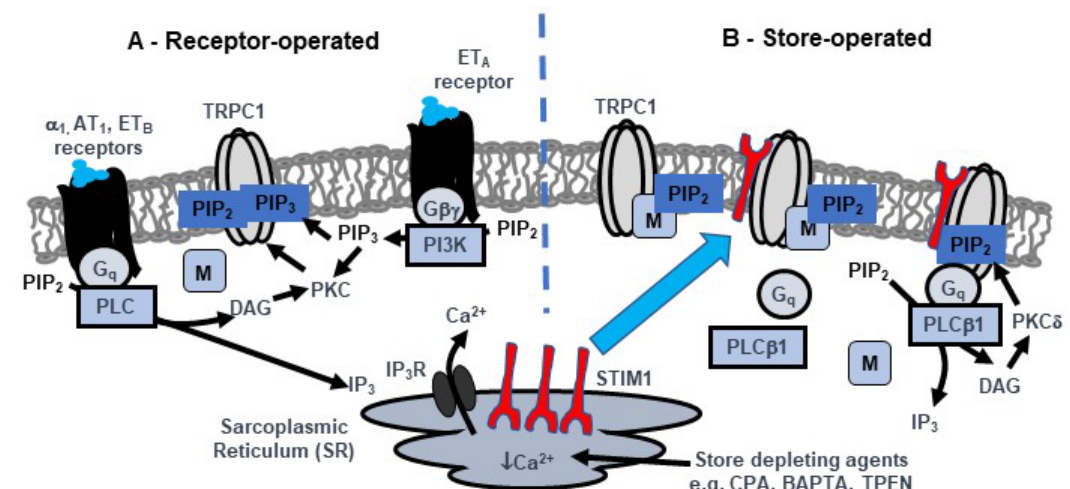
Figure 1. Proposed model of TRPC1-based store-operated channels (SOCs) in native contractile vascular smooth muscle cells (VSMCs) . A, Receptor stimulation of distinct Gq-PLC and G βγ -PI3K-PIP 3 pathways lead to PKC-dependent phosphorylation of TRPC1 and channel opening by PIP 2 and PIP 3 respectively. Local levels of PIP 2 involved in channel activation is controlled by MARCKS (M). B, Store depletion by receptor-mediated IP 3 generation and store depleting agents such as CPA, BAPTA and TPEN activate TRPC1-based SOCs through a STIM1-TRPC1-mediated pathway. In unstimulated cells, SR Ca 2 + stores are full and TRPC1-based SOCs are in a closed state. In this configuration, channels are associated with MARCKS which bu ff ers local PIP 2 levels and do not interact with Gq, PLC β 1 or STIM1. Following SR Ca 2 + depletion, STIM1 (red) is activated and translocates from the SR to the plasma membrane where it interacts with TRPC1. Formation of STIM1-TRPC1 interactions enable binding and activation of Gq and PLC β 1 activity, PIP 2 hydrolysis, DAG generation, stimulation PKC δ and PKC-dependent phosphorylation of TRPC1. This leads to dissociation of MARCKS from TRPC1 and release of PIP 2 (previously protected from PIP 2 hydrolysis) into the local environment where it acts as the activating